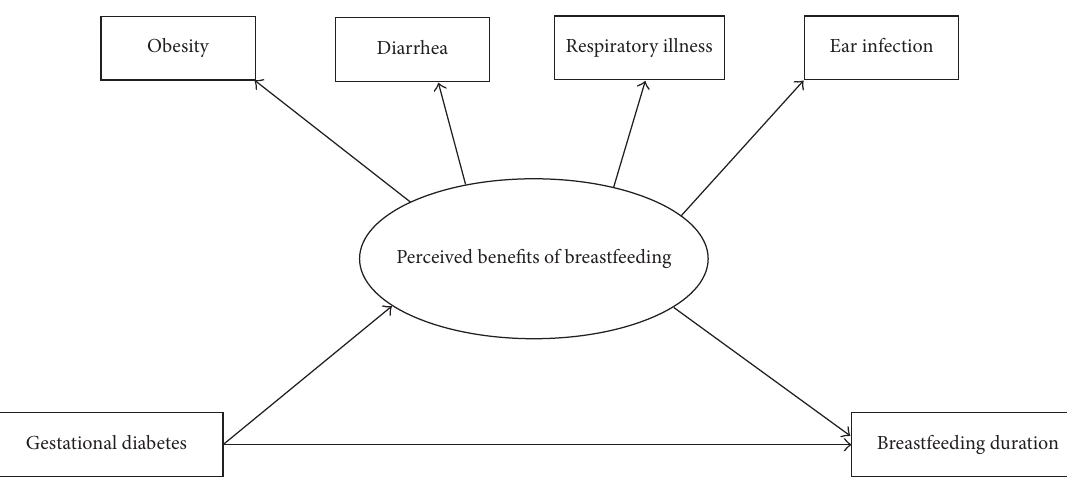
Figure 1: Gestational diabetes, perceived benefits of breastfeeding, and breastfeeding duration conceptual